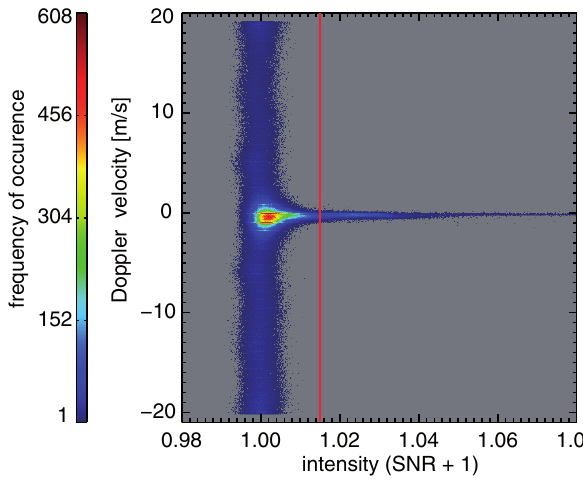
Figure 2. Intensity (SNR+1) vs. Doppler velocity plot based on Doppler lidar measurements from two different time pe- riods (06:00–07:00UTC 5 July 2013 and 07:00–08:00UTC 22 July 2013) which were characterized by quiescent atmospheric conditions, indicated by vertical velocities close to zero. The used Doppler lidar configuration was STARE, i.e. a continuous vertically pointing laser beam. For the range 0.992 < (SNR+1) < 1.006 the Doppler velocities are uniformly distributed over the search band ( ± 19.4ms − 1 ) indicating a relatively high fraction of “bad” esti- mates. For SNR+1 ≥ 1.008 the Doppler lidar delivers plausible val- ues (“good” estimates). The red line indicates the SNR-threshold (SNR+1)=1.015 used for the data analysis in the present